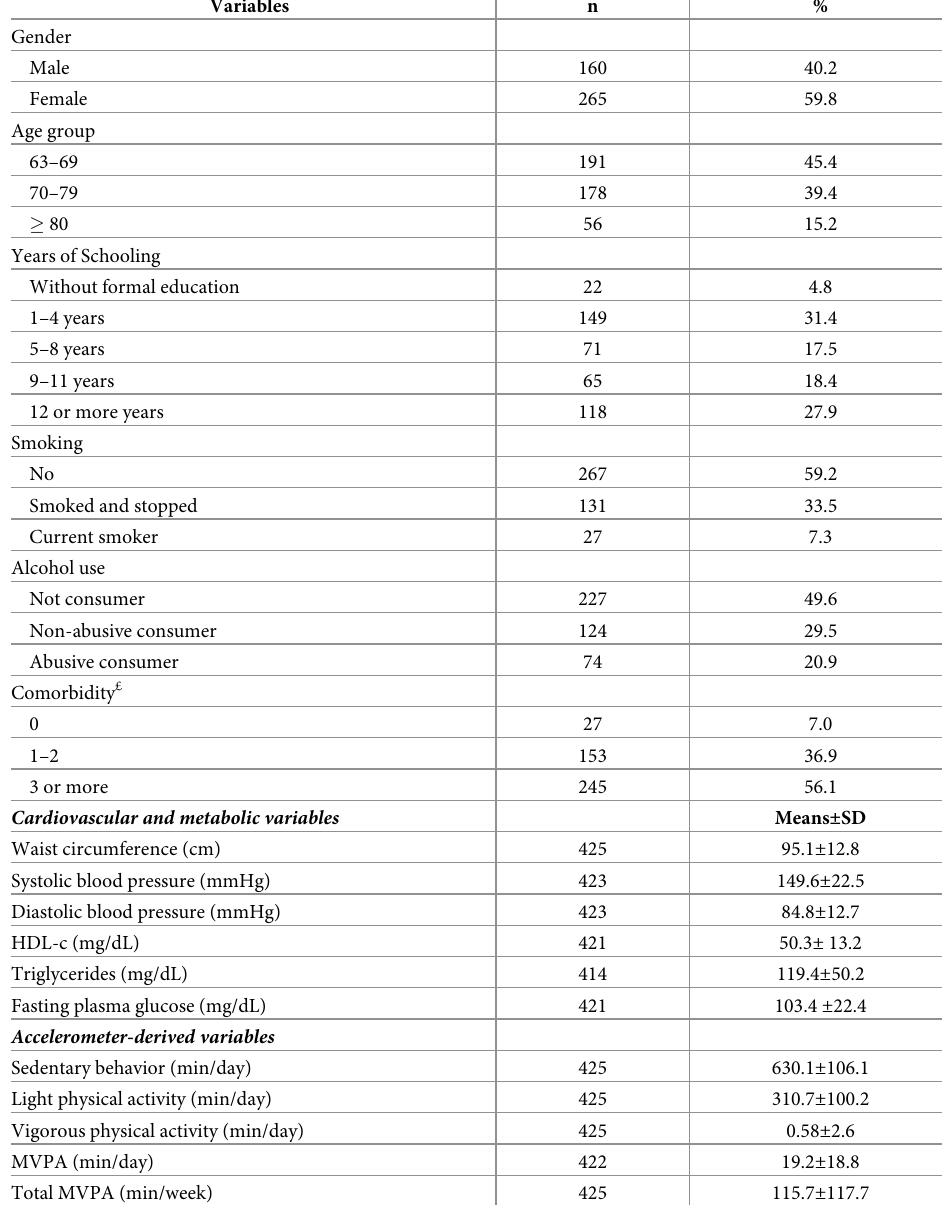
Table 1. Characteristics of participants with valid accelerometer data. EpiFloripa Idoso Study, Floriano´polis, Brazil, 2015, (n = 425).